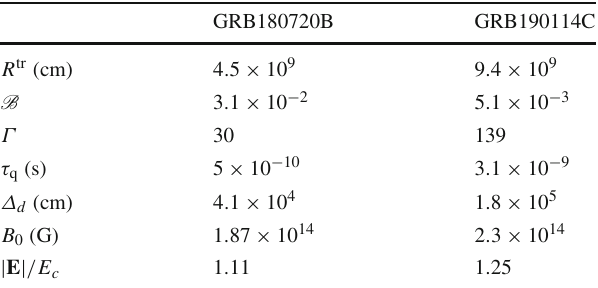
Table 3. The evolution of the PEMB pulse timescale,